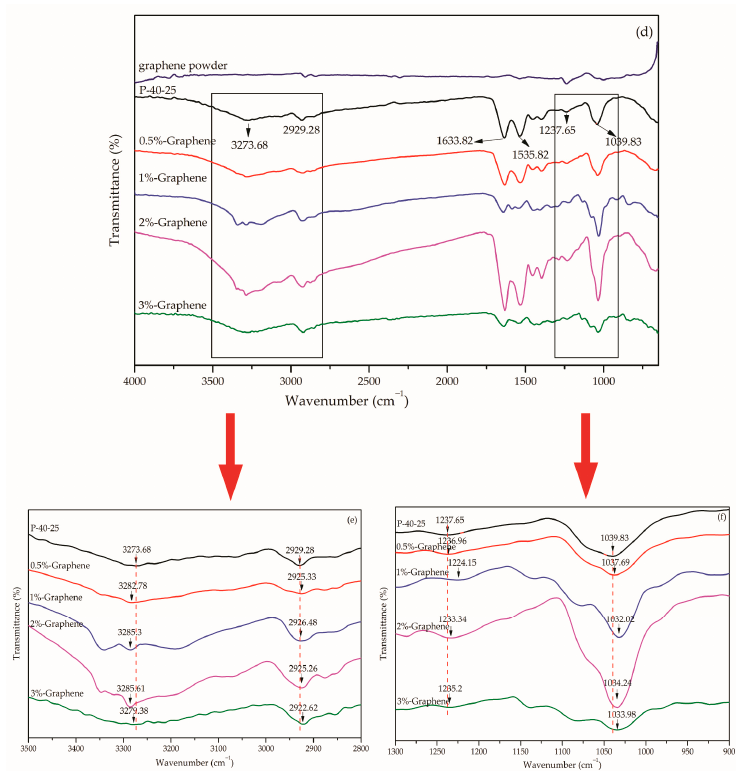
Figure 3. Fourier-transform infrared (FTIR) spectra for ( a ) GO powder and P-40-25 incorporated with GO in the region of 4000–650 cm − 1 , ( b ) P-40-25 incorporated with GO in the region of 3600–2900 cm − 1 , ( c ) P-40-25 incorporated with GO in the region of 1150–950 cm − 1 , ( d ) graphene powder and P-40-25 incorporated with graphene in the region of 4000–650 cm − 1 , ( e ) P-40-25 incorporated with